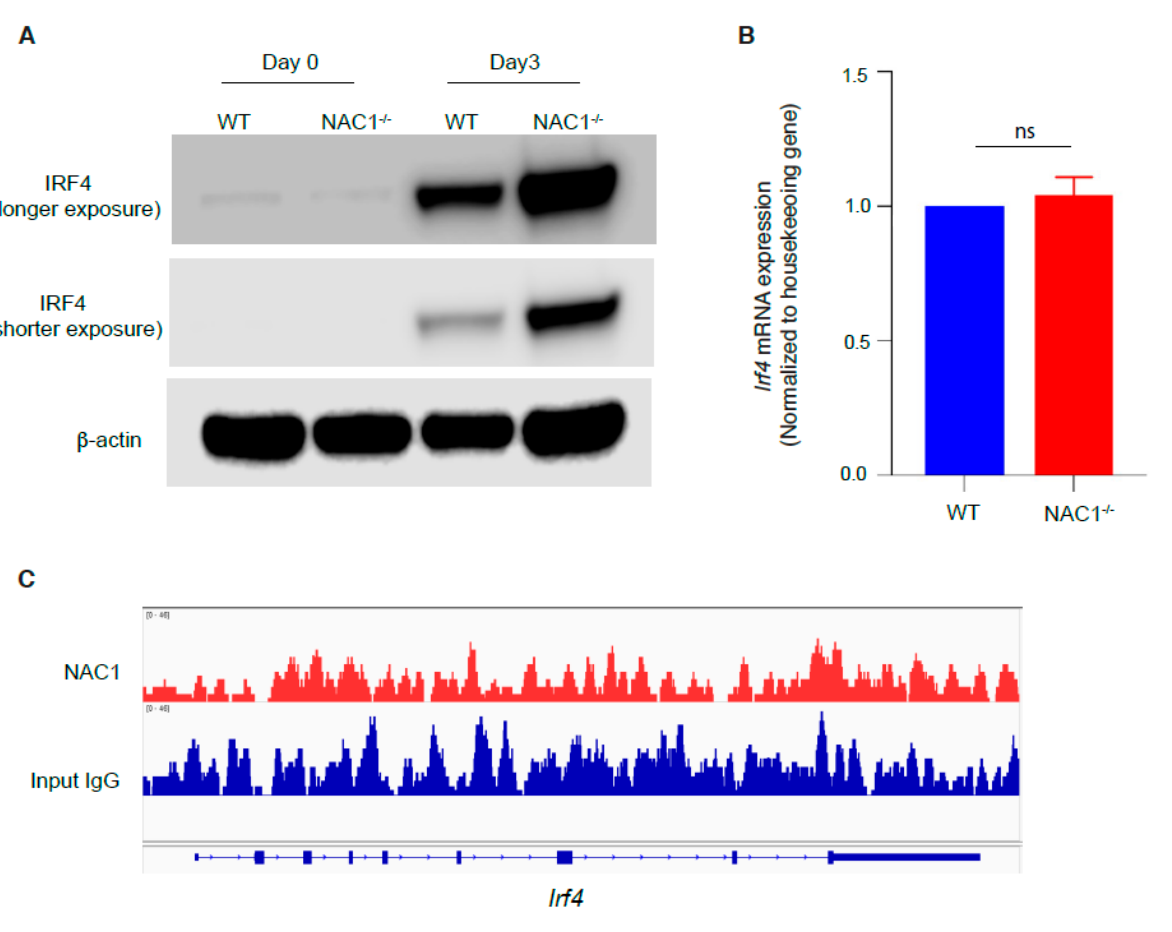
Figure 7. Regulation of IRF4 in CD8 + T cells by NAC1. CD8 + T cells were isolated from WT or NAC1 − / − mice and analyzed for expression of IRF4. ( A ) Protein expression by Western blot. For the day 0 sample, T cells were not activated. For the day 3 sample, T cells were activated and cultured for 3 days. ( B ) mRNA expression by Q-PCR. CD8 + T cells had been cultured for 3 days, and then RNA was extracted, and qPCR was performed (ns, p > 0.05). ( C ) CHIP-seq analysis. WT CD8 + T cells were isolated from mice and CHIP was performed with anti-NAC1 and anti-IgG Abs (Input control). The sequenced data was visualized by IGV.